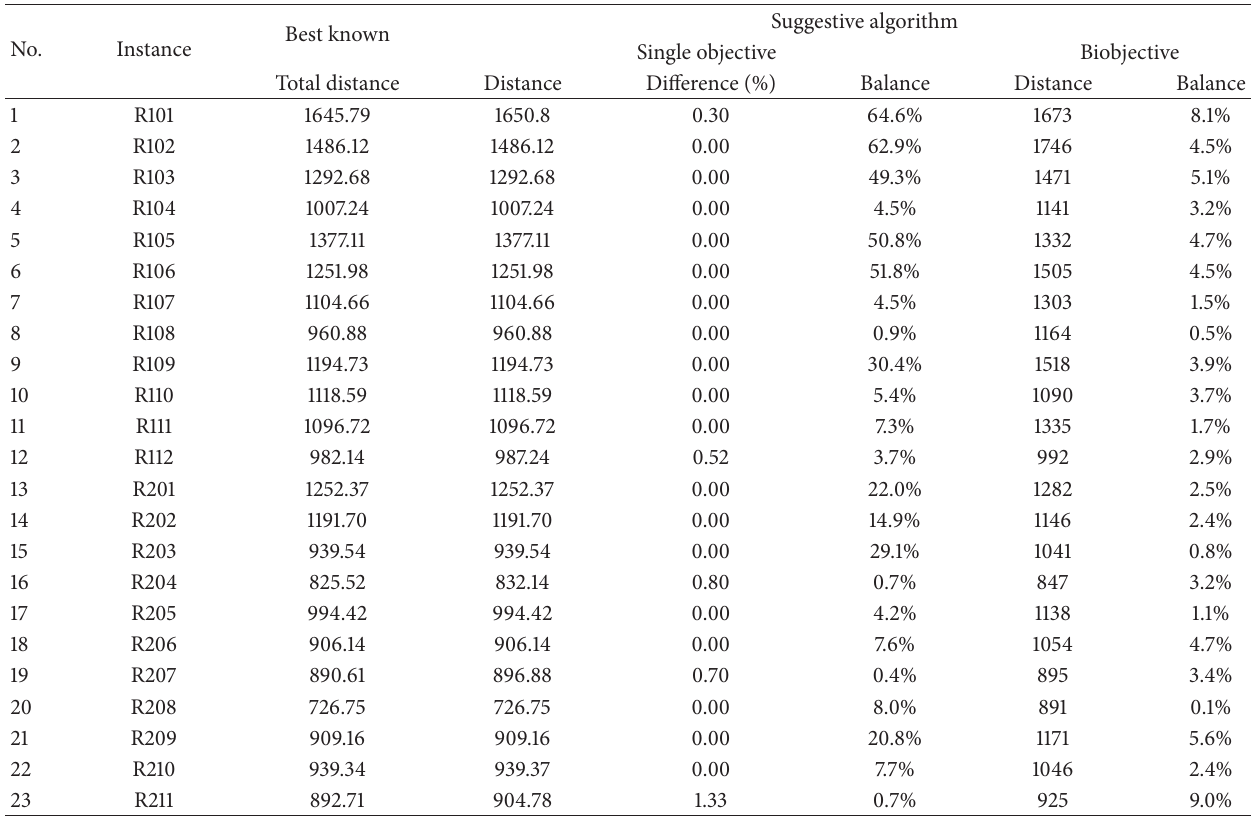
Table 2: Results of R